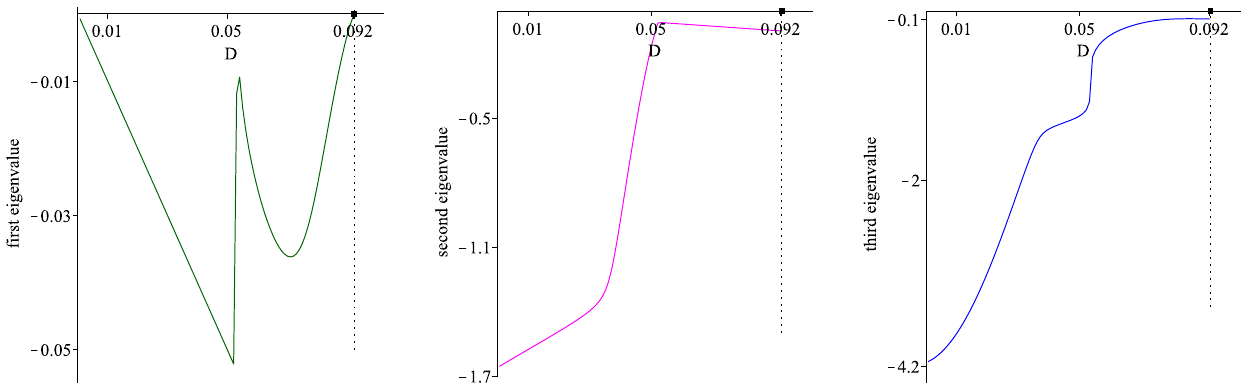
Figure 3. The three eigenvalues of the interior equilibrium E ∗ . The vertical dot lines pass through D max